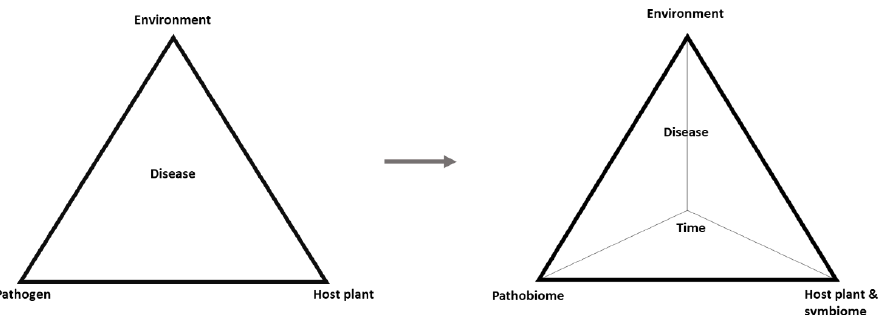
Figure 3. Plant pathology is currently witnessing a steady transition from the classical three- dimensional disease triangle to a more holistic view to explain plant disease through a four- dimensional disease pyramid, including time as the fourth dimension, representing the dynamics of the factors involved, and the plants are supported by the symbiome (beneficial organisms), reflecting a paradigm shift from the one pathogen–one disease hypothesis to the pathobiome concept.